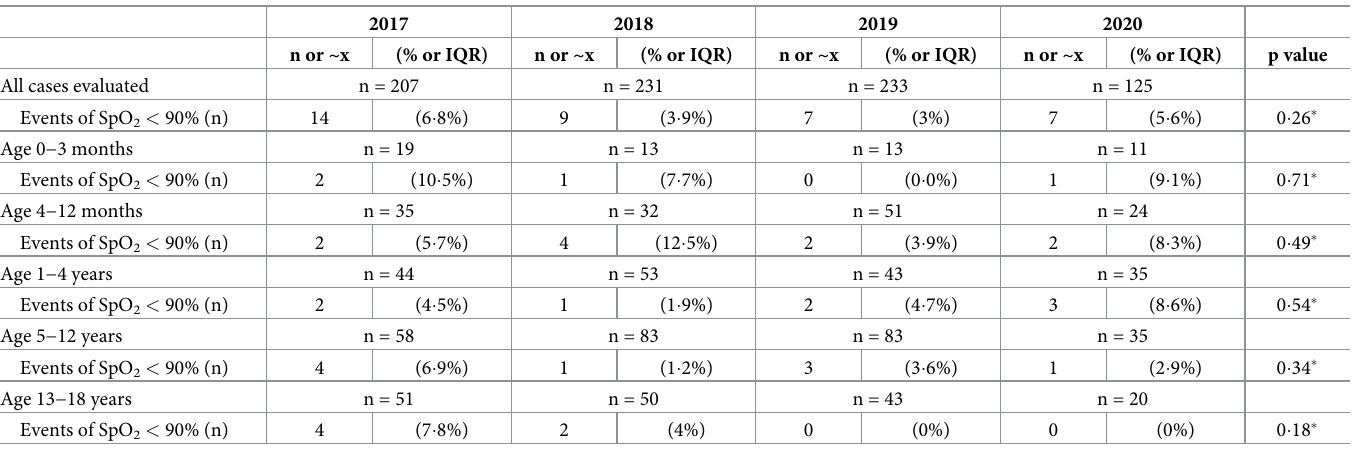
Table 3. Primary outcome parameter.